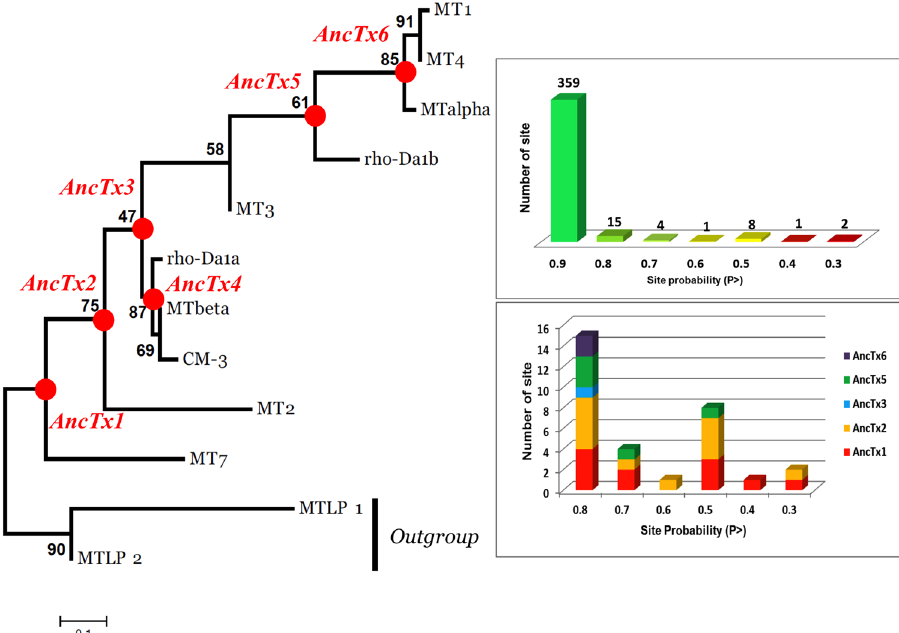
Figure 2. Maximum likelihood tree of the aminergic toxins. The best evolutionary model established by MEGA5 was the Dayhoff model using a discrete Gamma distribution ( + G). Bootstraps value higher than 50% are shown. MTLP-1 and 2 were used as out-group. Six ancestral sequences are figured on the nodes of the aminergic toxins tree. Quality of the reconstruction is shown on right side upper panel. For each site, a probability P is given. In total 390 sites were reconstructed. Among them, only 31 showed a P < 0.9, highlighting a good quality of the reconstruction. As shown in the lower panel, a high proportion of these ambiguous sites are presented in the sequences of AncTx1 and 2. The ambiguities were resolved by chosen the residues with the best probability. Due to the high divergence of MT7 and MT2 in term of sequence and function, this choice leads AncTx1 and 2 to be closer of AncTx3 and ρ -Da1a than